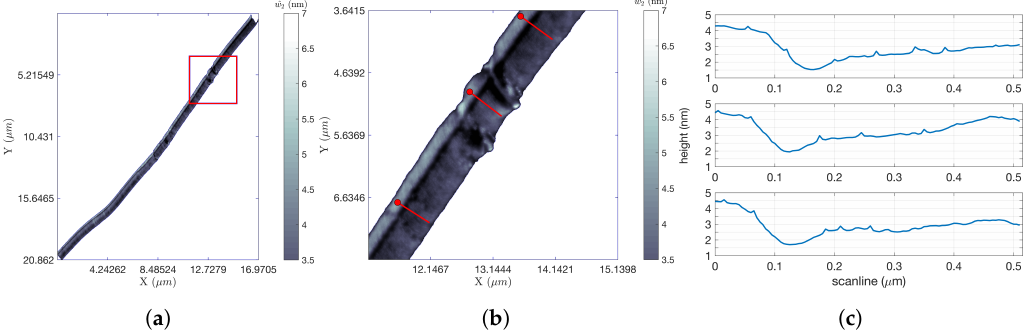
Figure 7. Si steps’ results. ( a ) LCS image (long scan). The white background indicates no information. The scan proceeded from the lower right to the upper left; the circular shape of the scan is revealed in the end of the image with the circular shape in the reconstructed image (LCS ˆ w 2 image, ω = 100 Hz); ( b ) A zoom in of the red box in ( a ) to show the detail (zoom of the red rectangle in ( a )); ( c ) Five hundred and fifteen nanometer-long scans generated from along the three red lines in ( b ); The top scan corresponds to the line in the top right, the middle scan to the line in the middle and the bottom scan to the line on the bottom. Each scan began at the end indicated by a circle. Step heights were approximately 1.5 nm (line scans along red lines in ( b )).